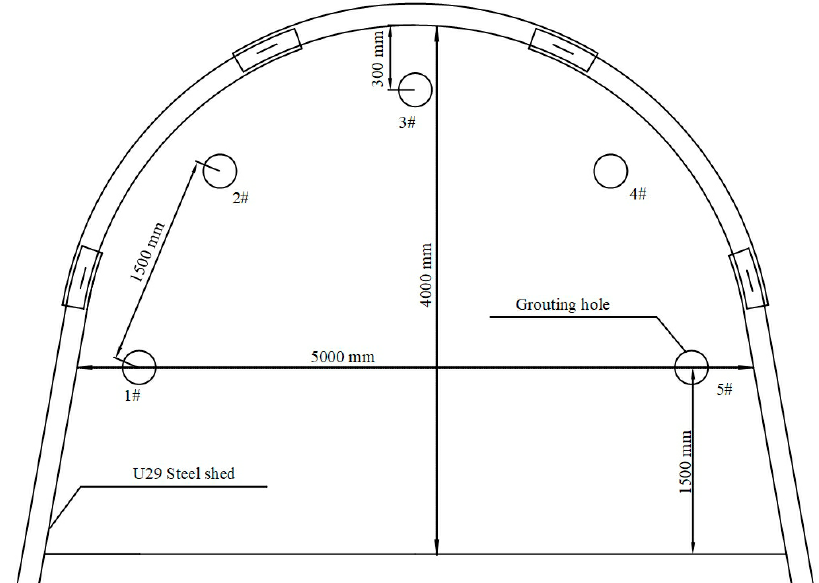
Figure 10. Roadway grouting hole layout.